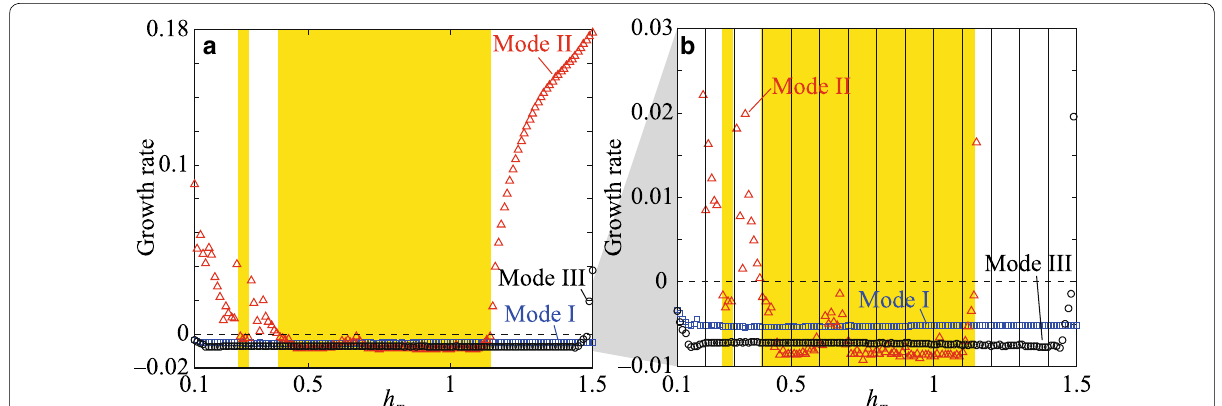
Fig. 7 a Growth rate obtained in the stability analysis using NL, and b a magnified plot around the neutral growth rate. Results for Mode I, II, and III are indicated by blue squares, red triangles, and black circles, respectively. Intersection of regions of stability for all modes are indicated in yellow